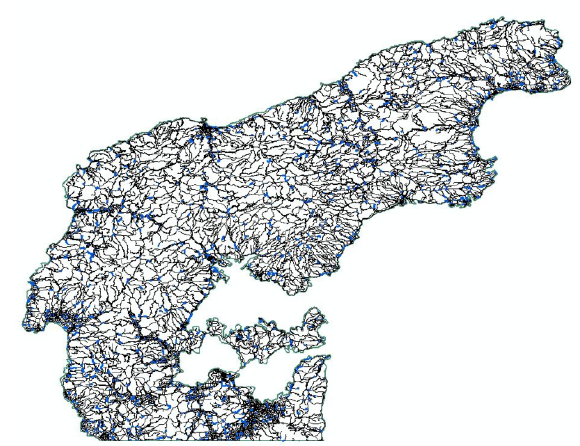
Figure 3. Samples in stratum of lines (blue lines represent Table 2. Confusion matrix of samples in the experimental samples).